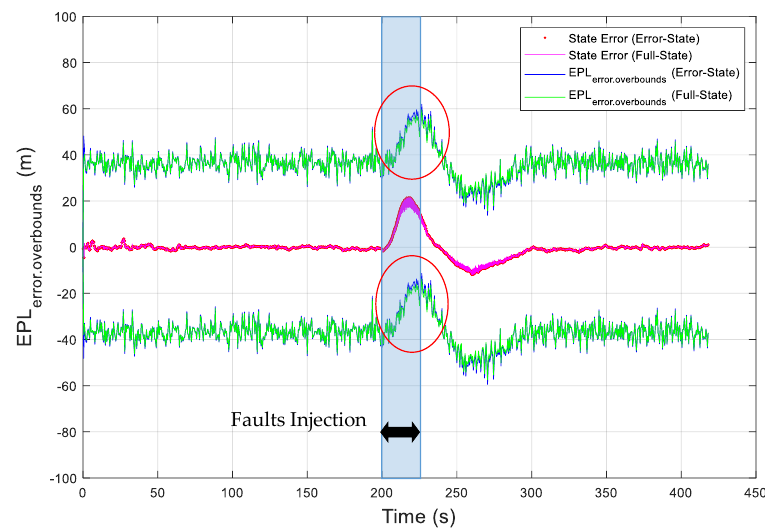
Figure 6. Simulation of the obtained error overboundings for the east position error.